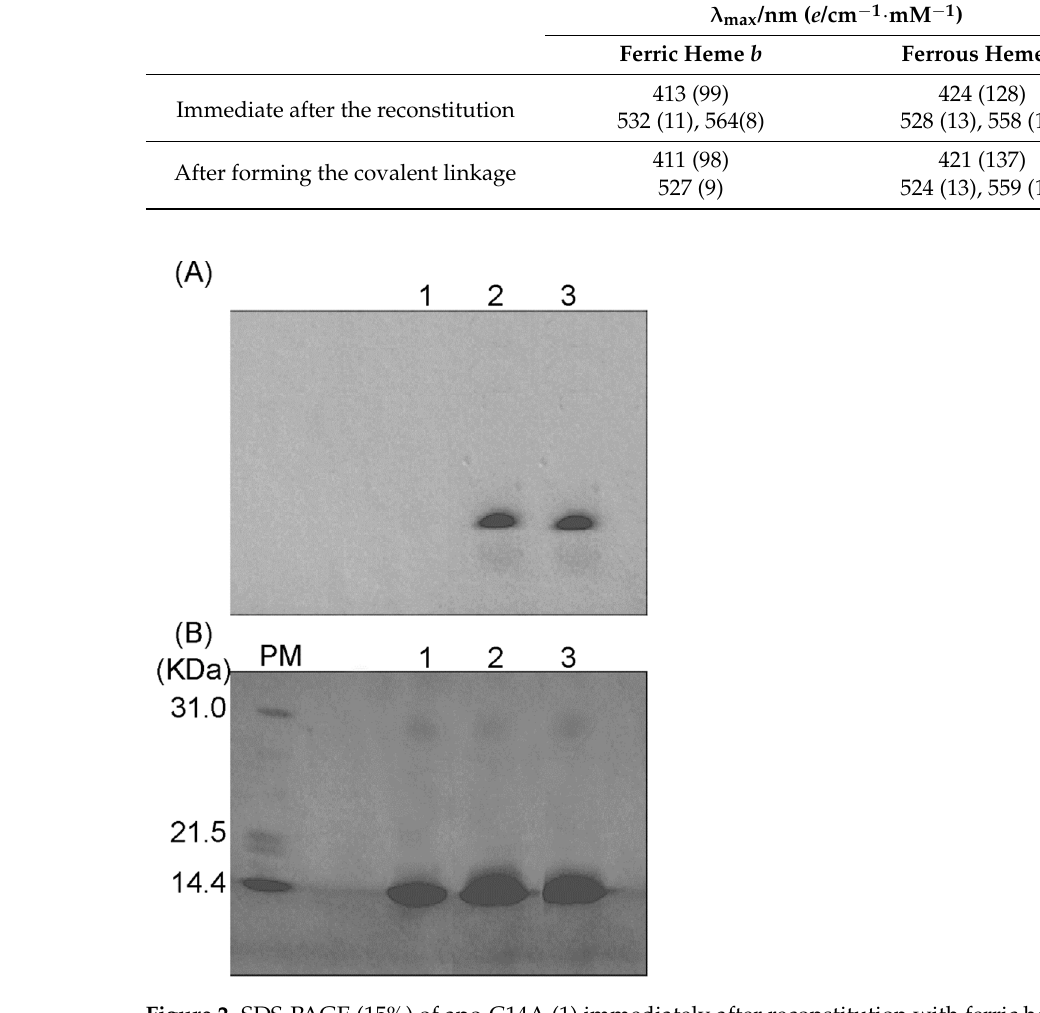
Figure 2. SDS-PAGE (15%) of apo-C14A (1) immediately after reconstitution with ferric heme, and reconstituted with (2) ferric and (3) ferrous heme b after showing the blue shifts in the UV-Vis spectra. ( A ) heme staining followed by ( B ) coomassie blue staining. PM: Protein marker.